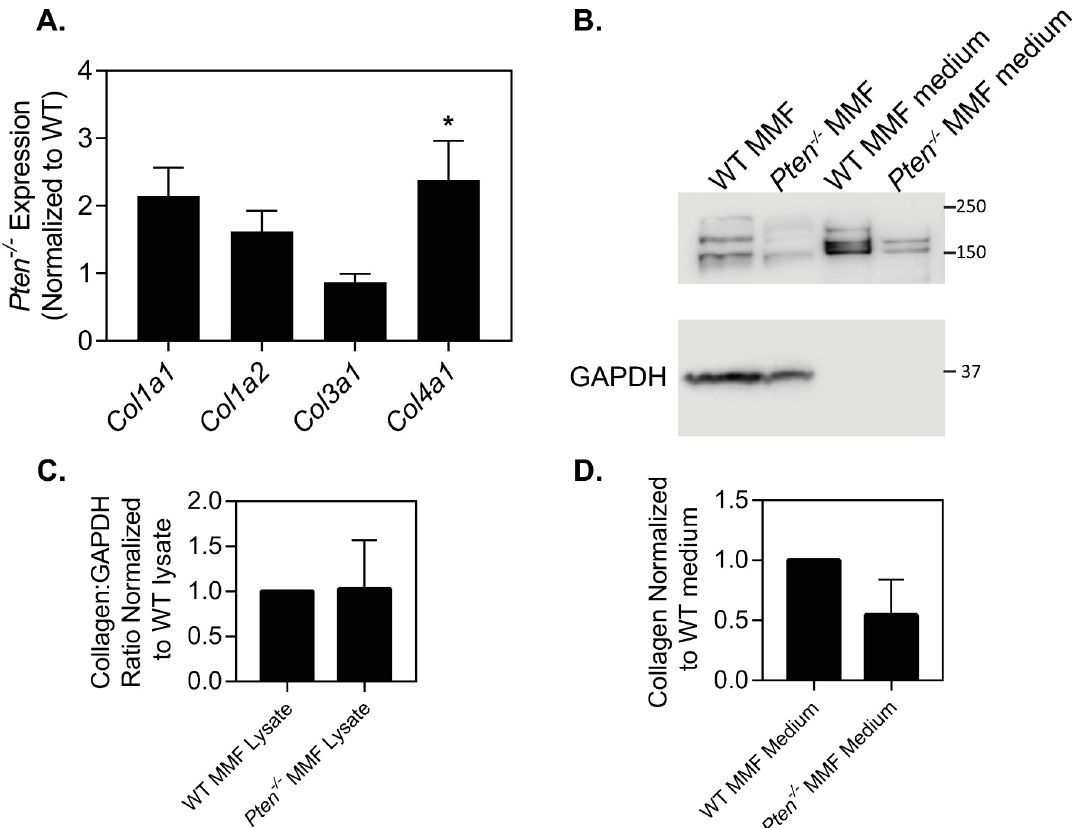
Fig 2. Pten knockout does not change collagen expression. (A) Normalized collagen mRNA expression, n = 5+SD. (B) Western blot of collagen I, with GAPDH used as a loading control for cell lysates. Individual bands likely represent procollagen, processing intermediates, and alpha subunit chains. (C) Quantification of collagen in cell lysates, normalized to WT. n = 3+SD. (D) Quantification of collagen in culture medium, normalized to WT. n = 3+SD. � p <